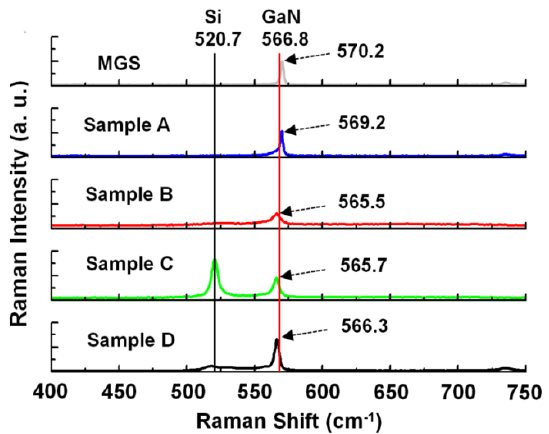
Figure 6. Raman spectra of GaN films for samples MGS (metalorganic chemical vapor deposition (MOCVD) ‐ grown GaN on sapphire), A, B, C, and D.